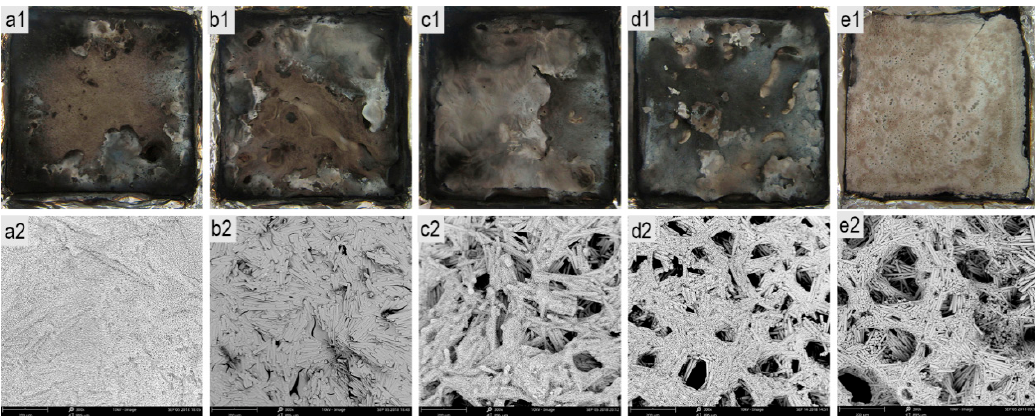
Figure 3. Digital photos ( a1–e1 ) and SEM photos ( a2–e2 ) of residue from cone calorimeter tests ( a1 , a2 ) 5%API/7%ADP/GF/PA6; ( b1 , b2 ) 3%API/9%ADP/GF/PA6; ( c1 , c2 ) 1%API/11%ADP/GF/PA6; ( d1 , d2 ) 12%ADP/GF/PA6; ( e1 , e2 ) GF/PA6.